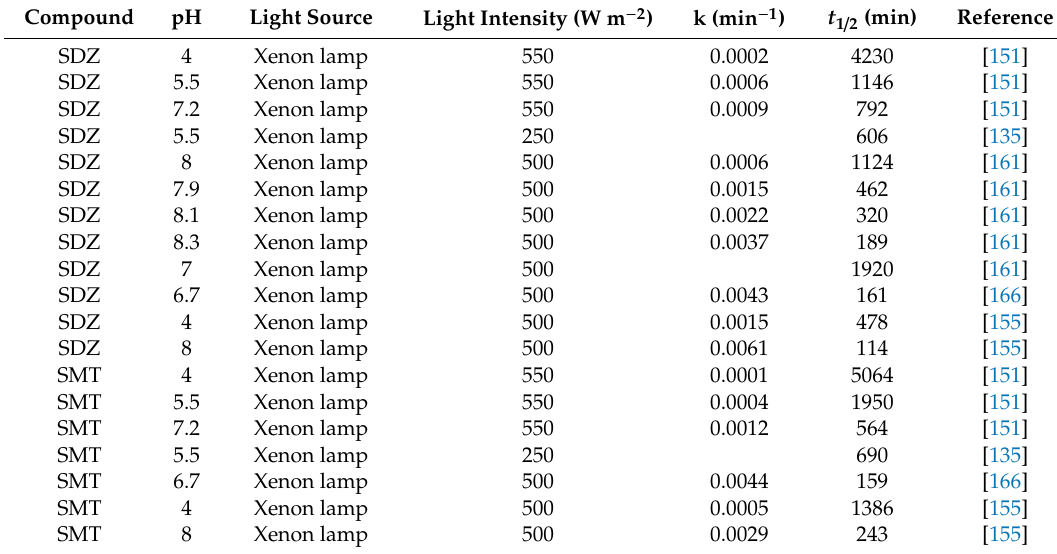
Velocity constant ( k ) and half-life ( t 1 / 2 ) values obtained by di ff erent authors for photodegradation of sulfonamide antibiotics in aqueous